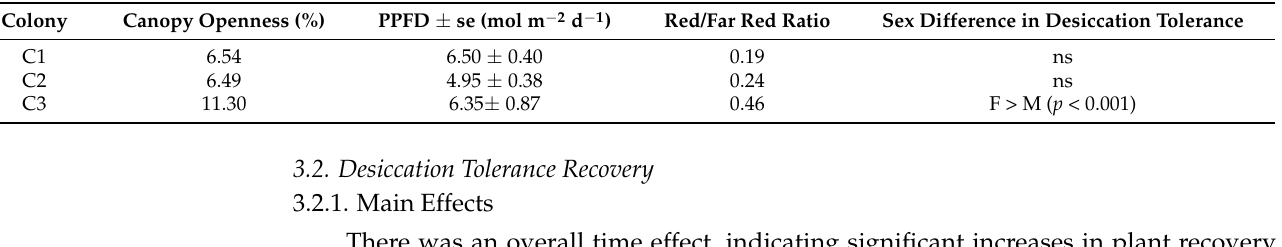
Table 1. Light related measures (canopy openness, PPFD and red to far-red ratio) and sex differences in desiccation tolerance among colonies.